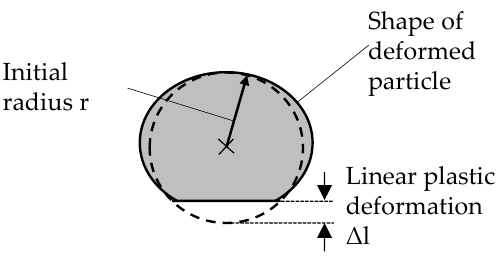
Figure 2. Definition of the determined linear plastic deformation (cf. [10]) .